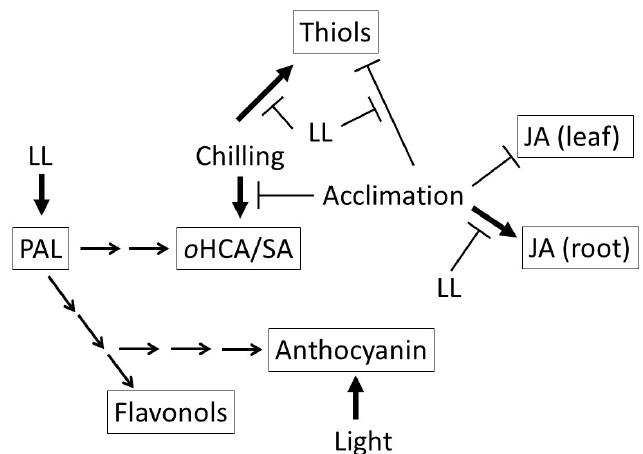
Figure 9. Schematic representation of the effect of the light on phenolic metabolism in young maize plants during cold acclimation. JA: jasmonic acid; LL: low light intensity (107 µ mol m − 2 s − 1 ) during cold acclimation; ortho-hydroxycinnamic acid (oHCA); phenylalanine ammonia lyase (PAL). Supplementary Materials: Supplementary Materials can be found at www.mdpi.com/xxx/s1. Table S1: BLASTX search hits of cold- and light-induced significantly differentially expressed transcripts related to hormone biosynthesis. Table S2: BLASTX search hits of cold- and light-induced significantly differentially expressed transcripts related to thiol metabolism. Table S3: BLASTX search hits of cold- and light-induced significantly differentially expressed transcripts related to flavonoid metabolism.